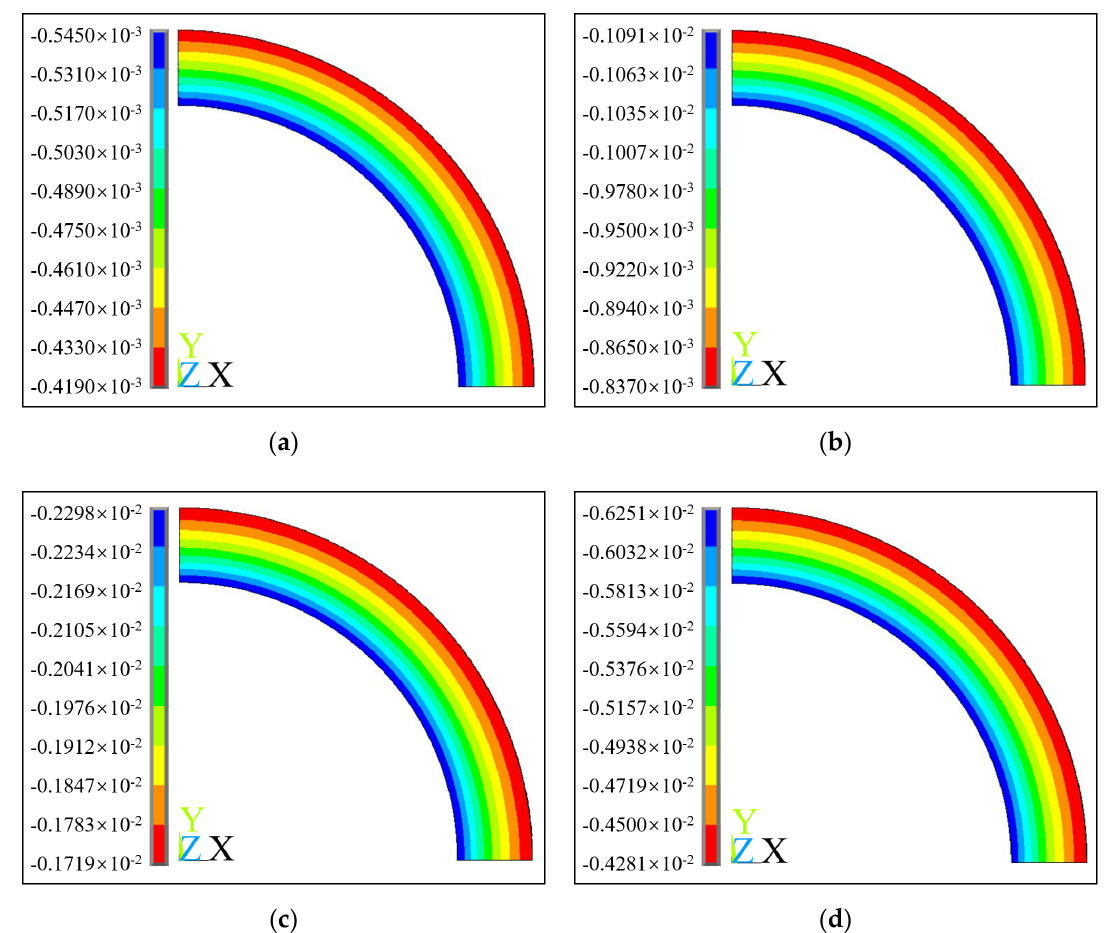
Figure 7. Hoop strain cloud diagrams of D-2 model shaft lining concrete under a surface load: ( a ) 5 MPa; ( b ) 10 MPa; ( c ) 17 MPa; ( d ) 20.9 MPa.